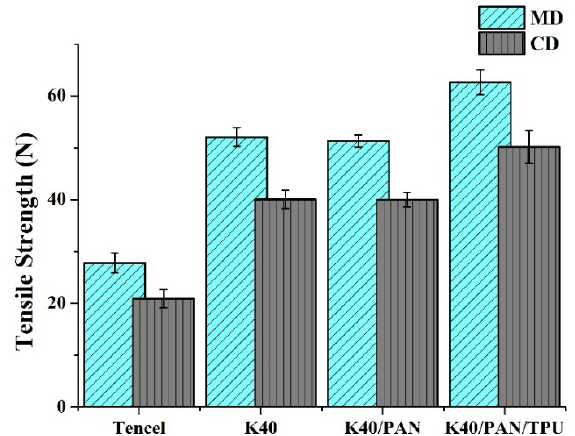
Figure 2. Tensile strength along the MD and CD of Tencel, K40, and K40/PAN/TPU lay-up com- pound matrices.